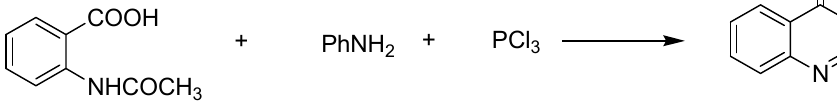
Figure 2. Synthesis of 3,4 dihydro-4-oxaquinazoline.